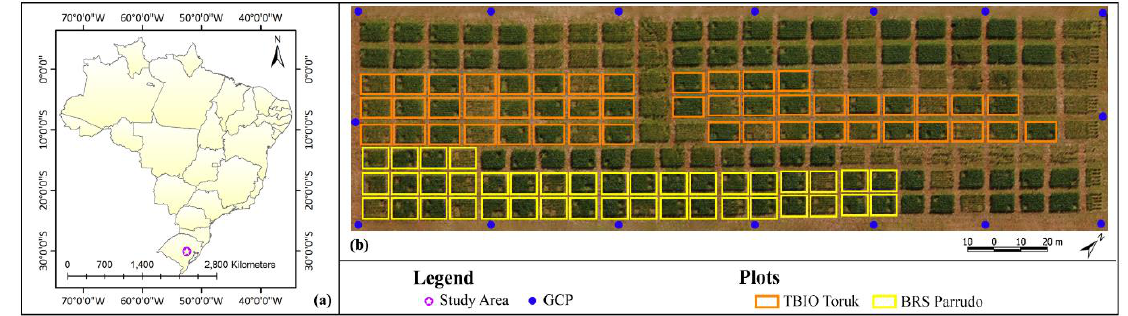
Figure 1 . Schematic overview of (a) the study site location in Eldorado do Sul, Brazil, and (b) the experimental plot design with TBIO Toruk and BRS Parrudo varieties